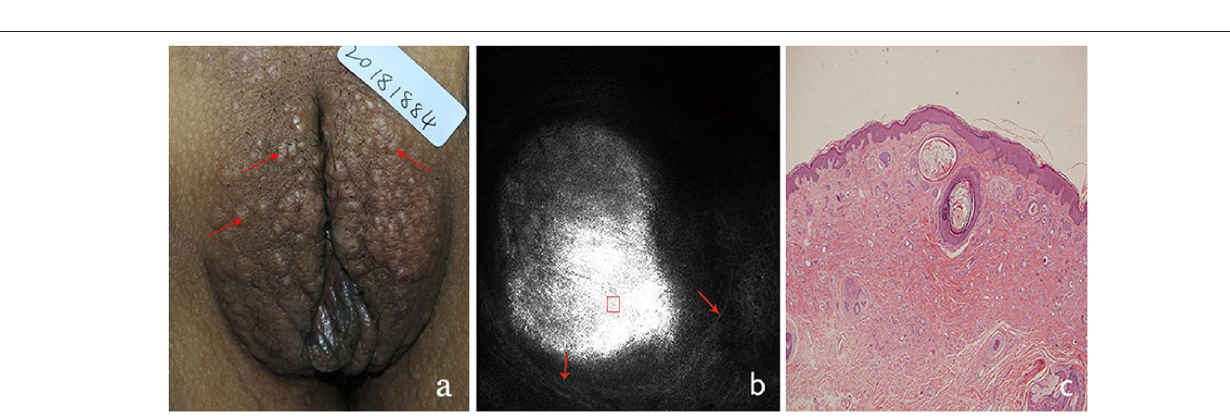
FIGURE 4 | The clinical presentation, RCM findings and histology of vulva syringoma (case 4). (a) , the clinical image of case 4, (b) , the RCM image findings; (c) , the histological findings.